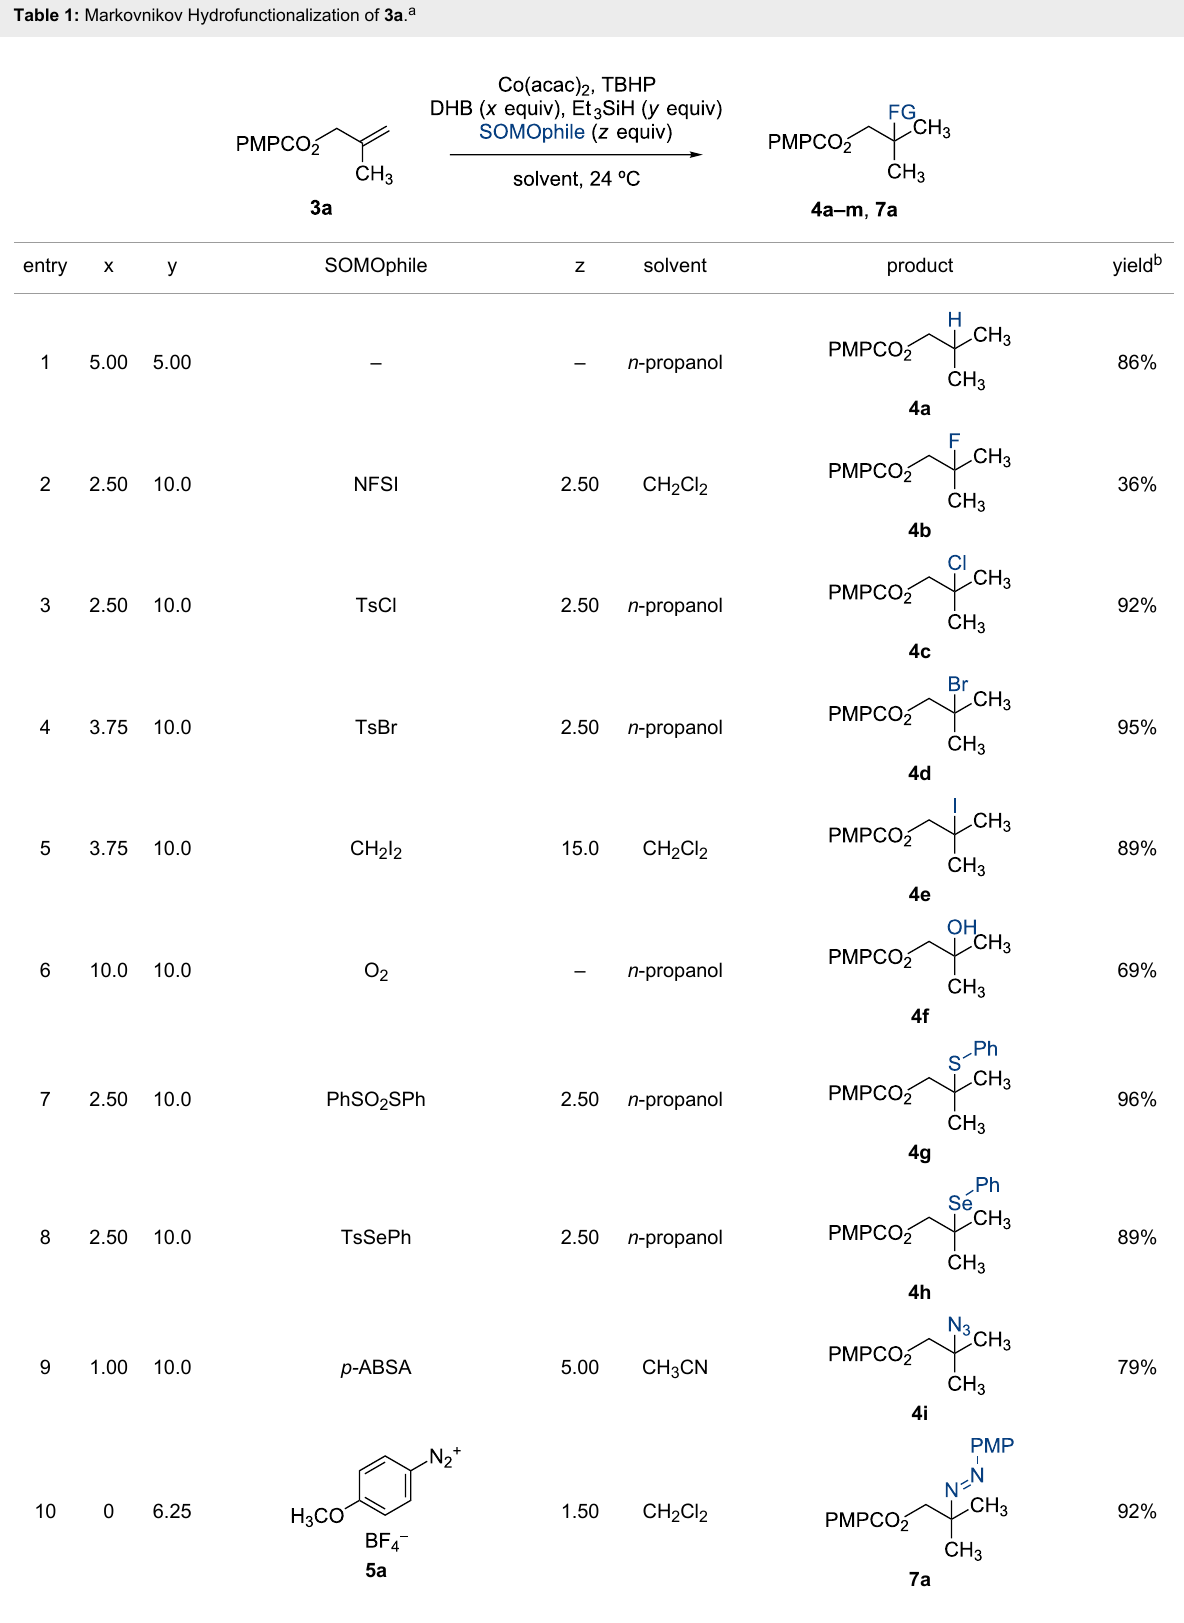
Table 1: Markovnikov Hydrofunctionalization of 3a .